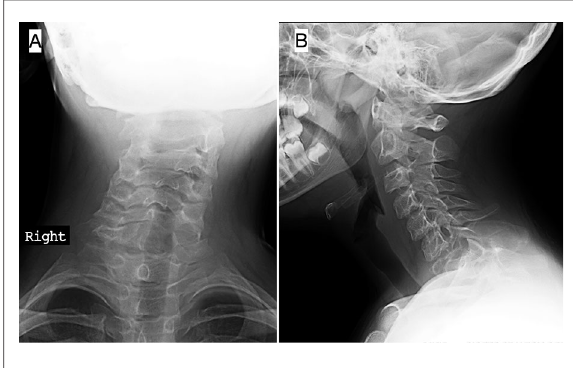
FIGURE 1 Anteroposterior and lateral radiographs of the cervical spine: ( A ) Osteolytic expansive lesion on C7 vertebral body, with ill-de fi ned borders, expansion and interruption of the upper and lower endplate of the left half of the vertebral body and absent spinous process and left pedicle; also, abnormal cervical alignment in the frontal plane with a slight left-sided tilt of the neck is noted. ( B ) Enlargement of the posterior elements and upper endplate of C7 vertebral body, thinning of the cortical bone, without apparent interruption, periosteal reaction, or soft tissue